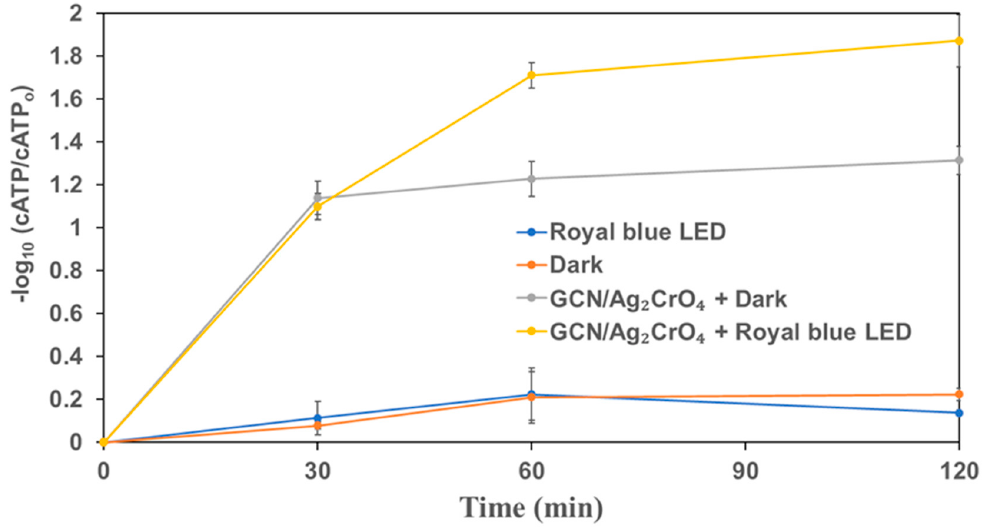
Figure 6. The change of ATP in wastewater secondary effluent in the presence of GCN/Ag 2 CrO 4 with and without royal blue LED irradiation.